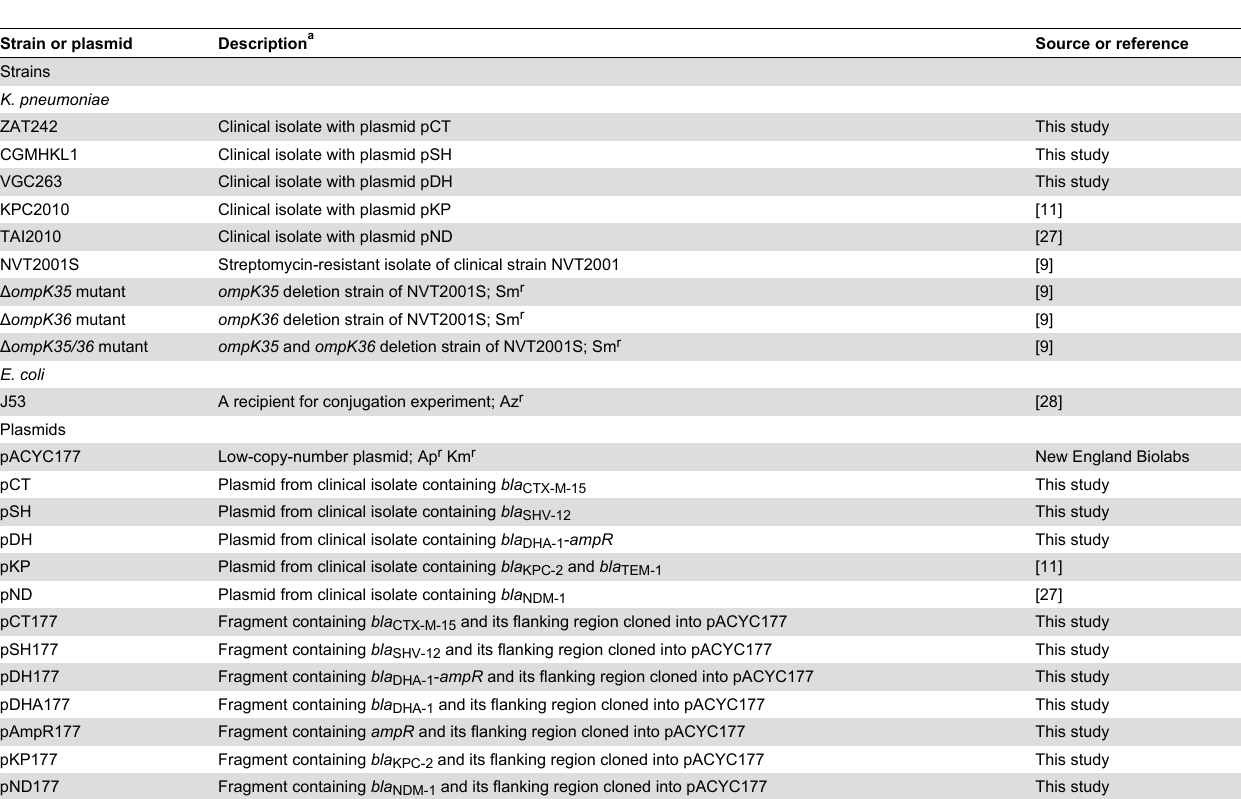
Table 1. Bacterial strains and plasmids used in this